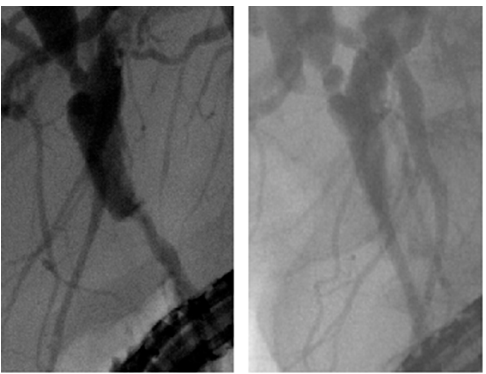
Figure 1. Cholangiocarcinoma before ( left ) and after ( right ) RFA with common bile duct remodel- ing.